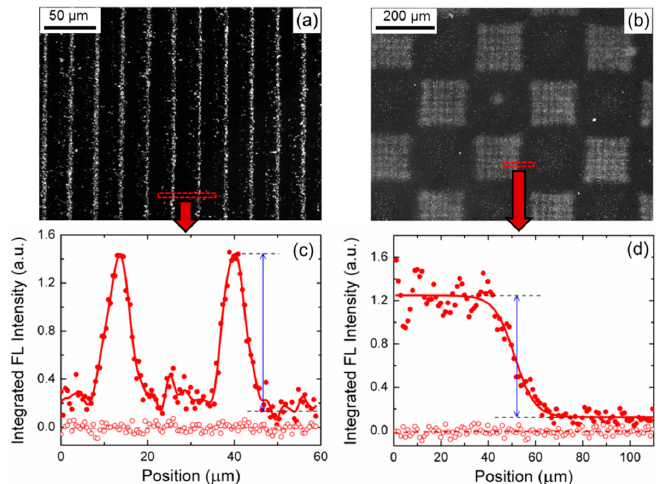
Figure 5. Fluorescence microphotographs of ( a ) a 1D fringe pattern and ( b ) a 2D checkered pattern. ( c , d ) show the corresponding micro ‑ luminescence profiles of a region in the patterns. Taken from Martínez ‑ Muñoz et al. J. Phys. Conf. Ser. 2017 , 867 , 012030 (reference [37]).